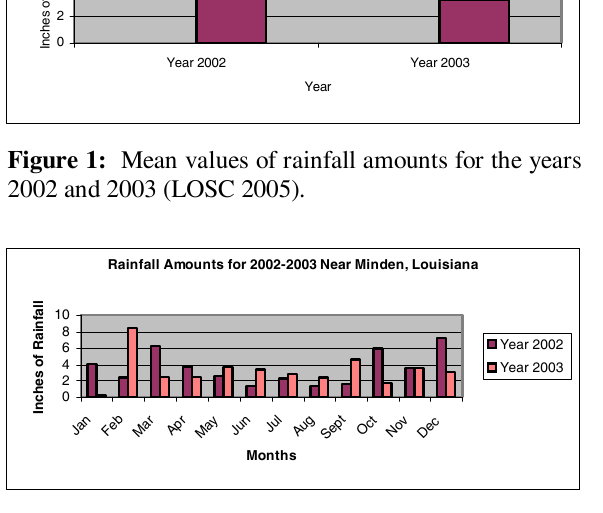
Figure 2: Rainfall amounts for 2002 and 2003 near Minden, Louisiana (LOSC 2005).